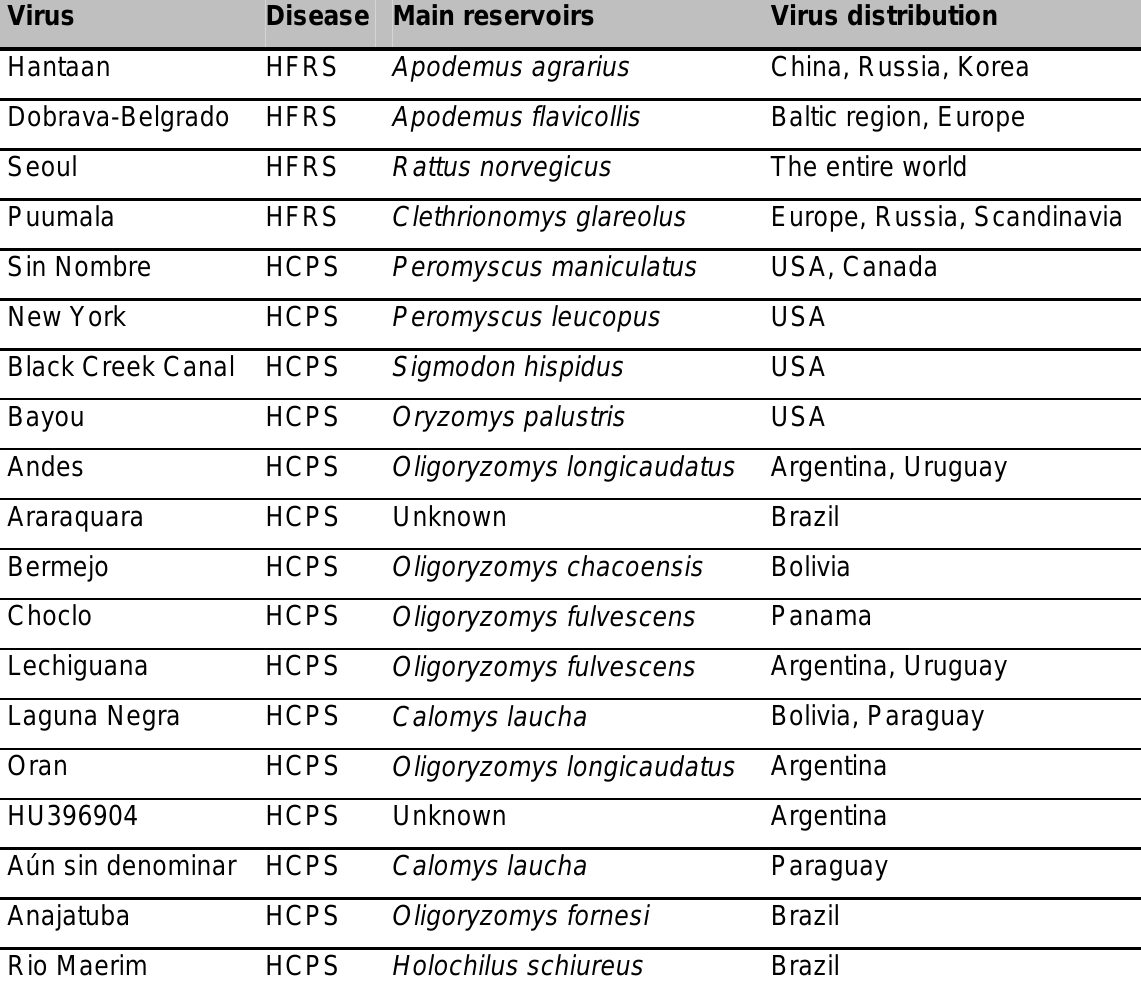
Table 1. Hantaviruses and human diseases: highlighting viral type,